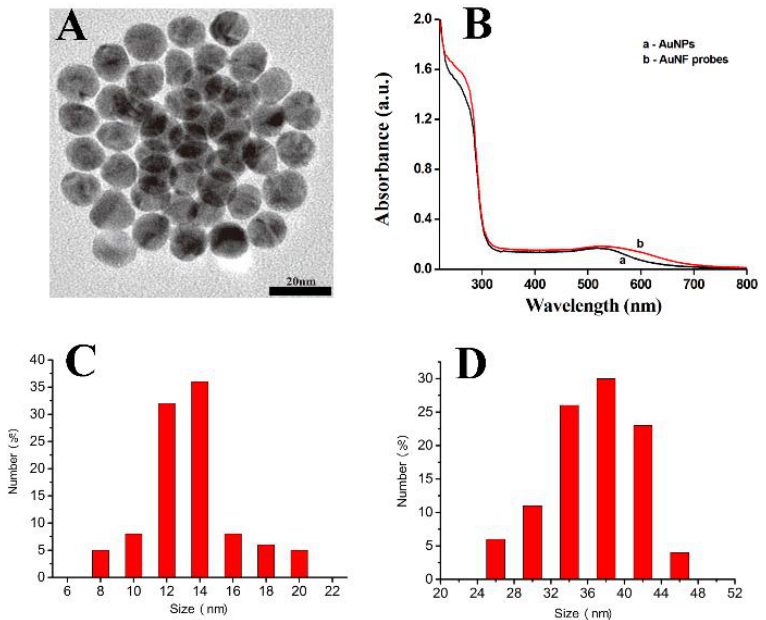
Figure 2. TEM images of AuNPs ( A ), UV-vis characterization of AuNPs and AuNF probes ( B ), hy- drodynamic sizes of AuNPs ( C ) and AuNF probes ( D ) determined by